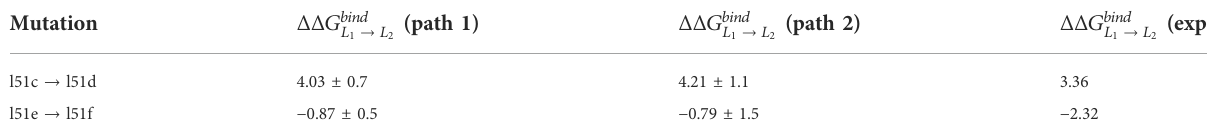
TABLE 3 ΔΔ G bind L for the mutations l51c → l51d, l51e → l51f in the FXa model system along two different paths (see also Figure 4). 1 → L 2